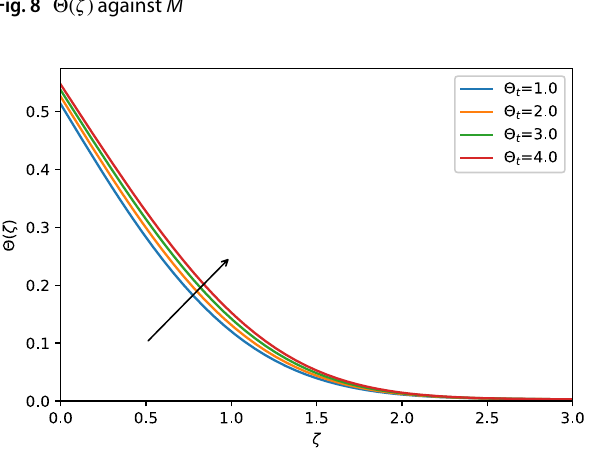
Fig. 10 Θ( 𝜁 ) against A